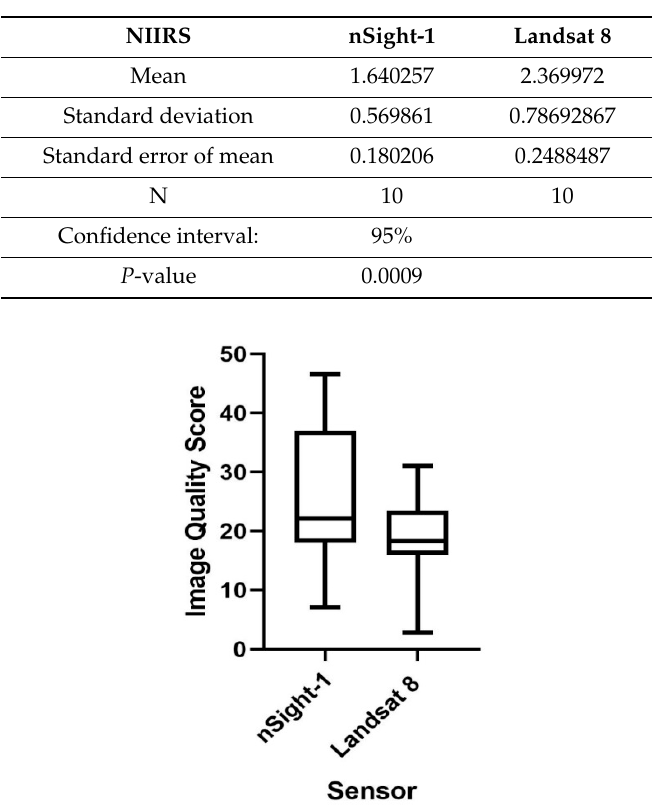
Figure 3. Image quality score box and whisker diagram.